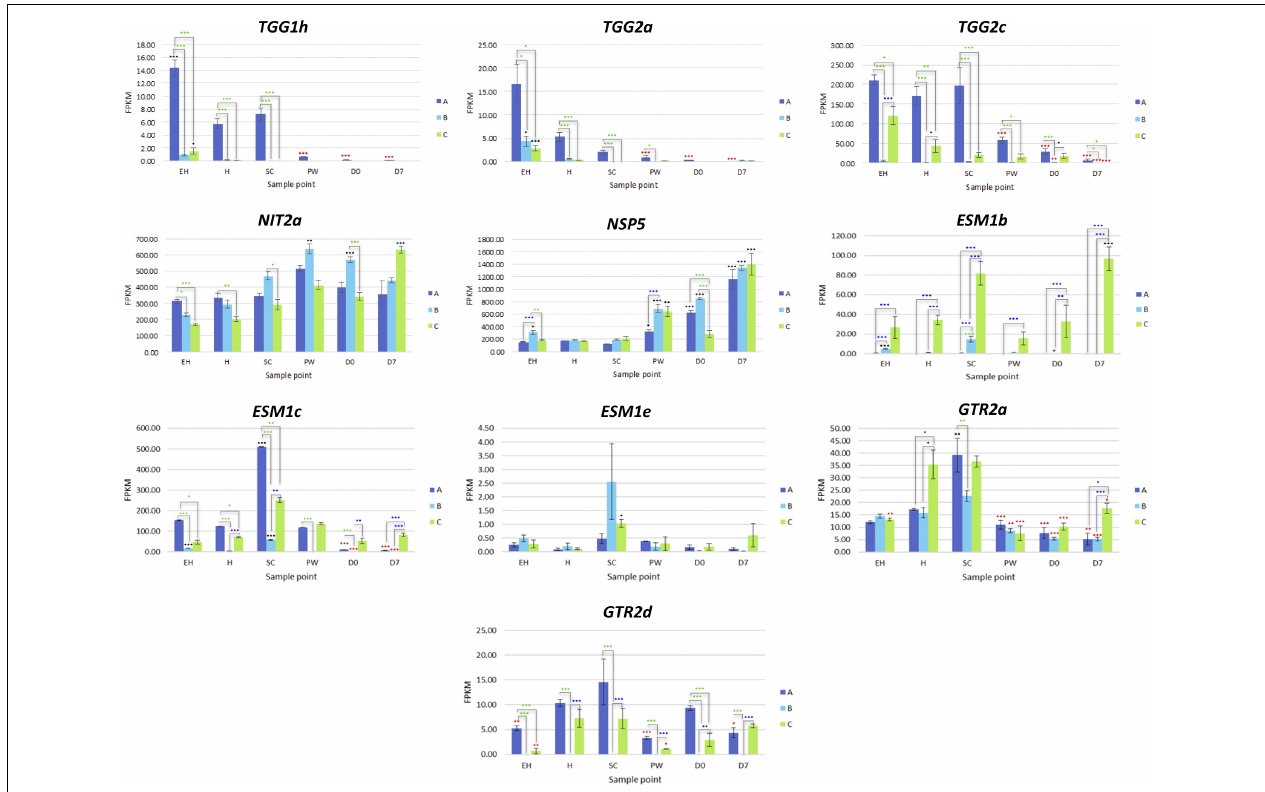
FIGURE 9 | RNAseq expression data (FPKM) for genes involved with glucosinolate hydrolysis and transport in three elite inbred lines of Eruca sativa ( A , dark blue; B , light blue; C , green). Standard errors of the mean expression values are represented by error bars. Asterisks denote levels of significance of up and down regulation within sample points (between each inbred line) and relative to the point of harvest for each respective sample point: * p ≤ 0.05; ** p ≤ 0.01; *** p ≤ 0.001; green, significant up regulation between lines A , B , and C ; blue, significant down regulation between lines A , B , and C ; black, significant up regulation relative to H ; red, significant down regulation relative to H . EH , early harvest; H , harvest; SC , second harvest; PW , pre-wash; D0 , post-wash; and D7 , 7-day shelf